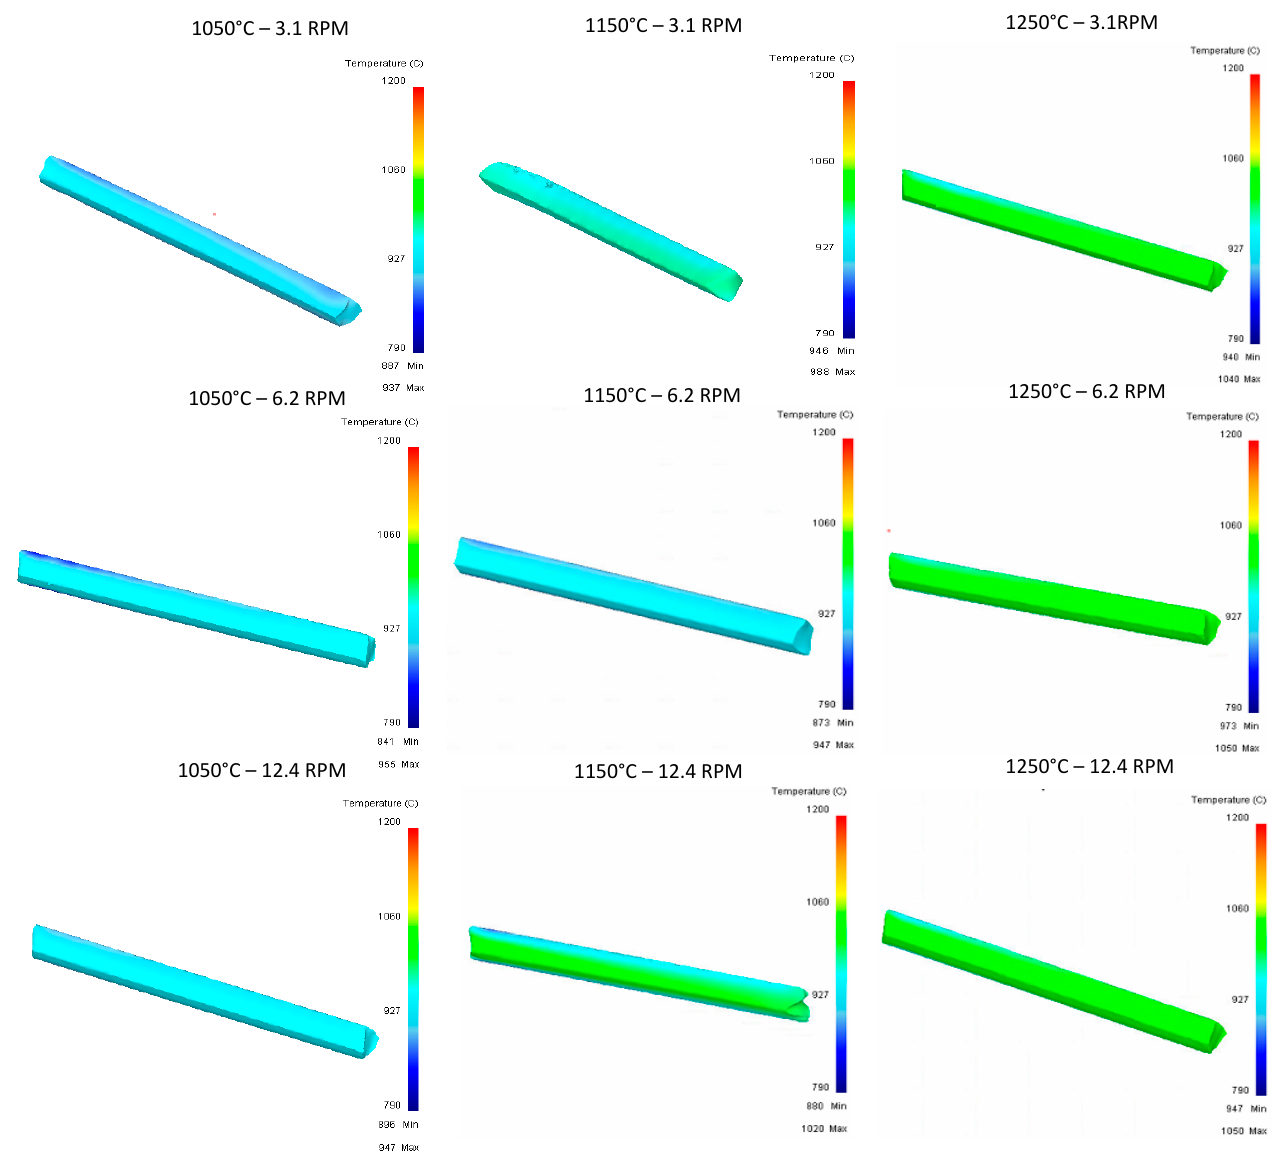
Figure 24. Upper Rail temperature graph for fifth pass.